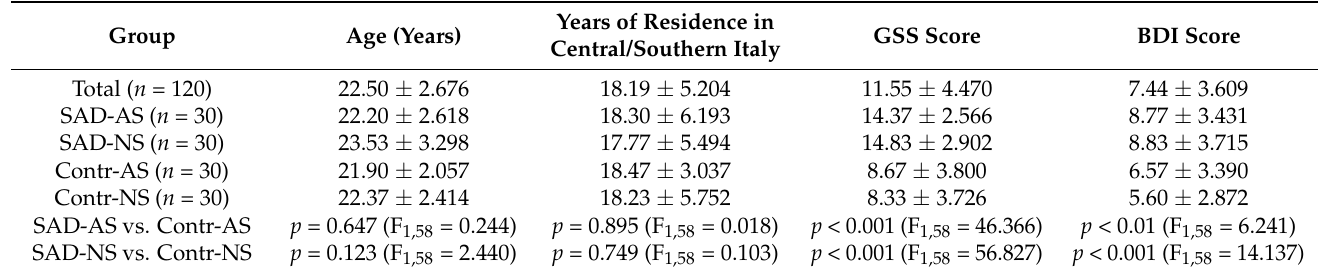
Table 1. Demographic and clinical characteristics of the four groups. Data are presented as the mean ± SD. p = level of significance.